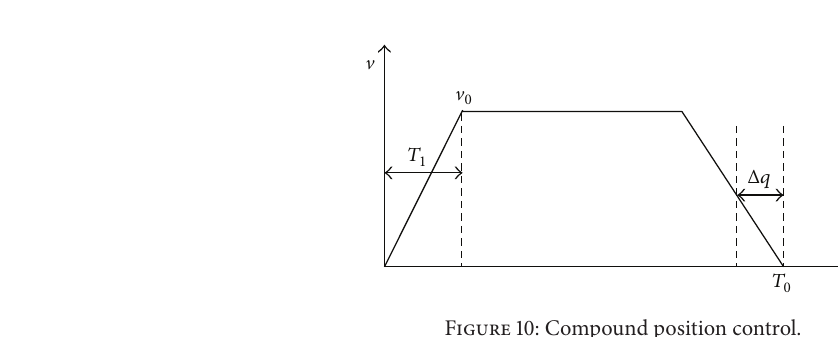
Figure 10: Compound position control.